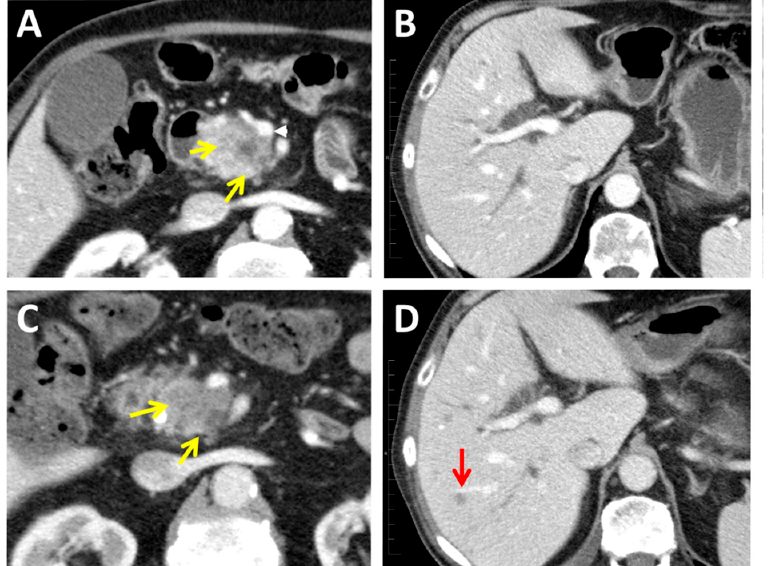
Figure 2. Occult micro-metastatic disease is common in PDAC, often undetected by current radiology techniques. Case. ( A ) At the time of diagnosis, a CT found 37 mm pancreatic head tumor (yellow arrows) contacting > 50% with the superior mesenteric vein (white arrow) with no liver metastasis ( B ) and classified as a resectable stage T3 N0 M0. In a CT performed just 4 weeks after the basal one, the pancreatic mass was stable (yellow arrows) ( C ), but liver metastases were found (red arrow) ( D ), the tumor re-staged as a T3 N0 M1, and the tumor surgical excision was not indicated anymore.